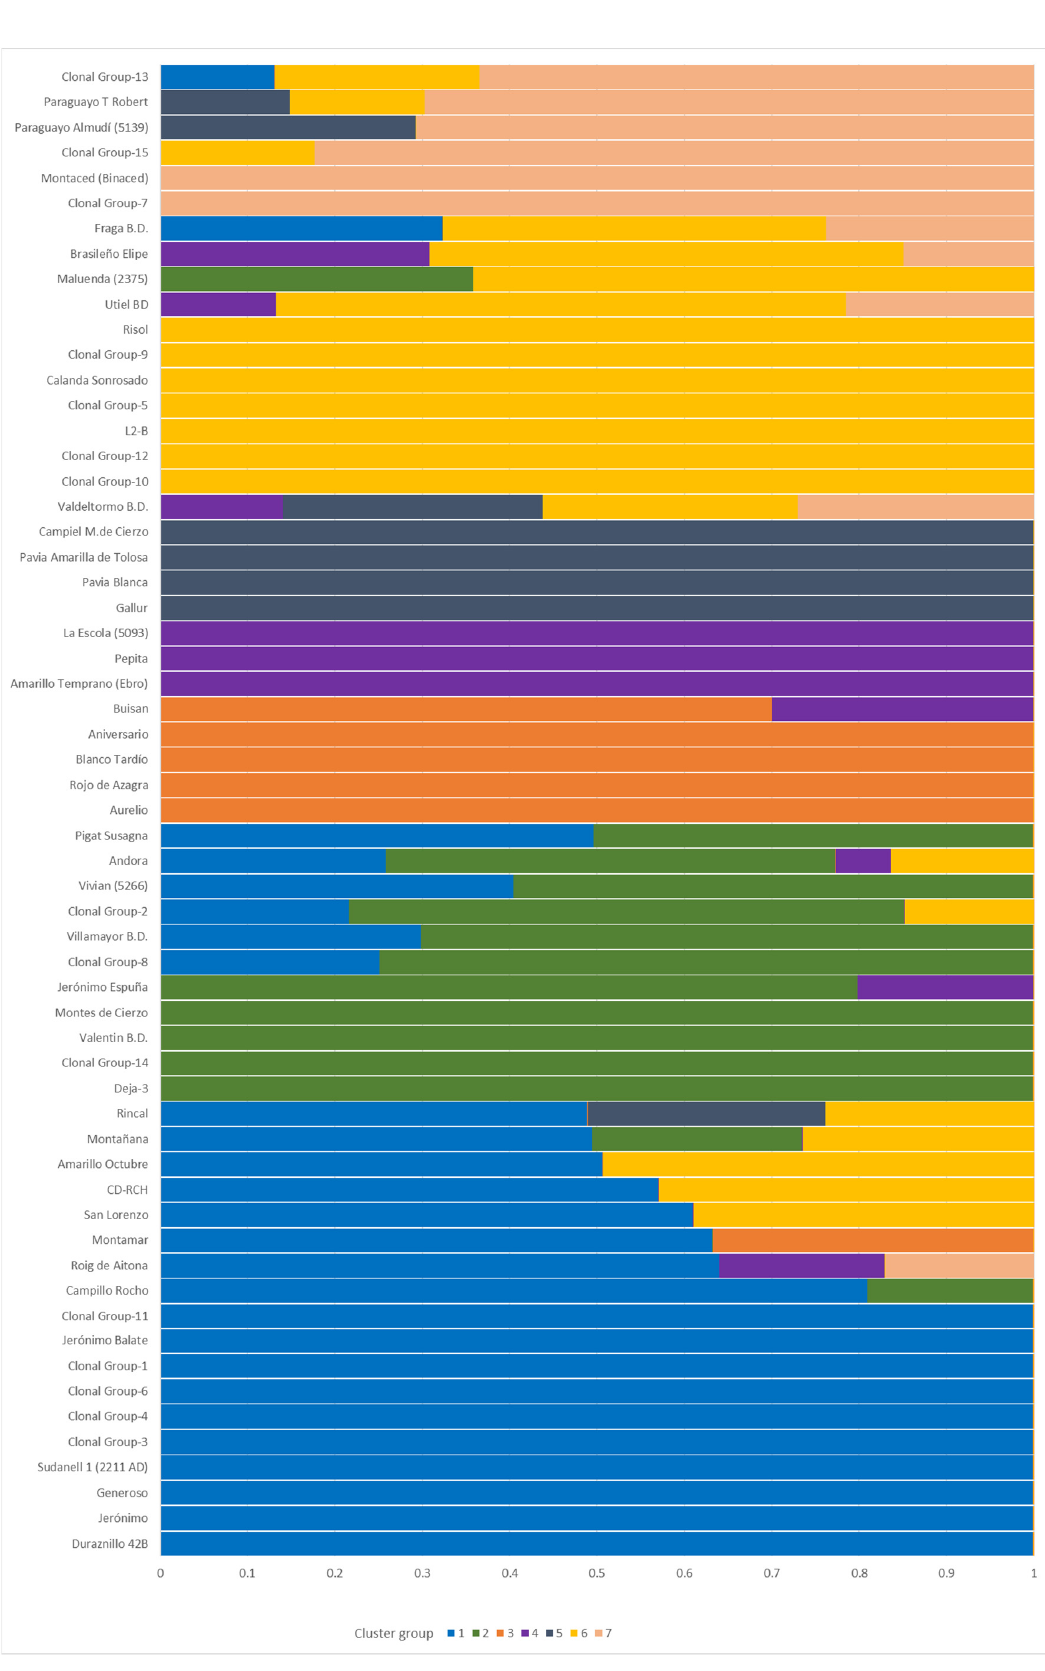
Figure 4. A more detailed representation of the genetic structure obtained in fastStructure (k = 7). The x-axis represents the membership coefficient.